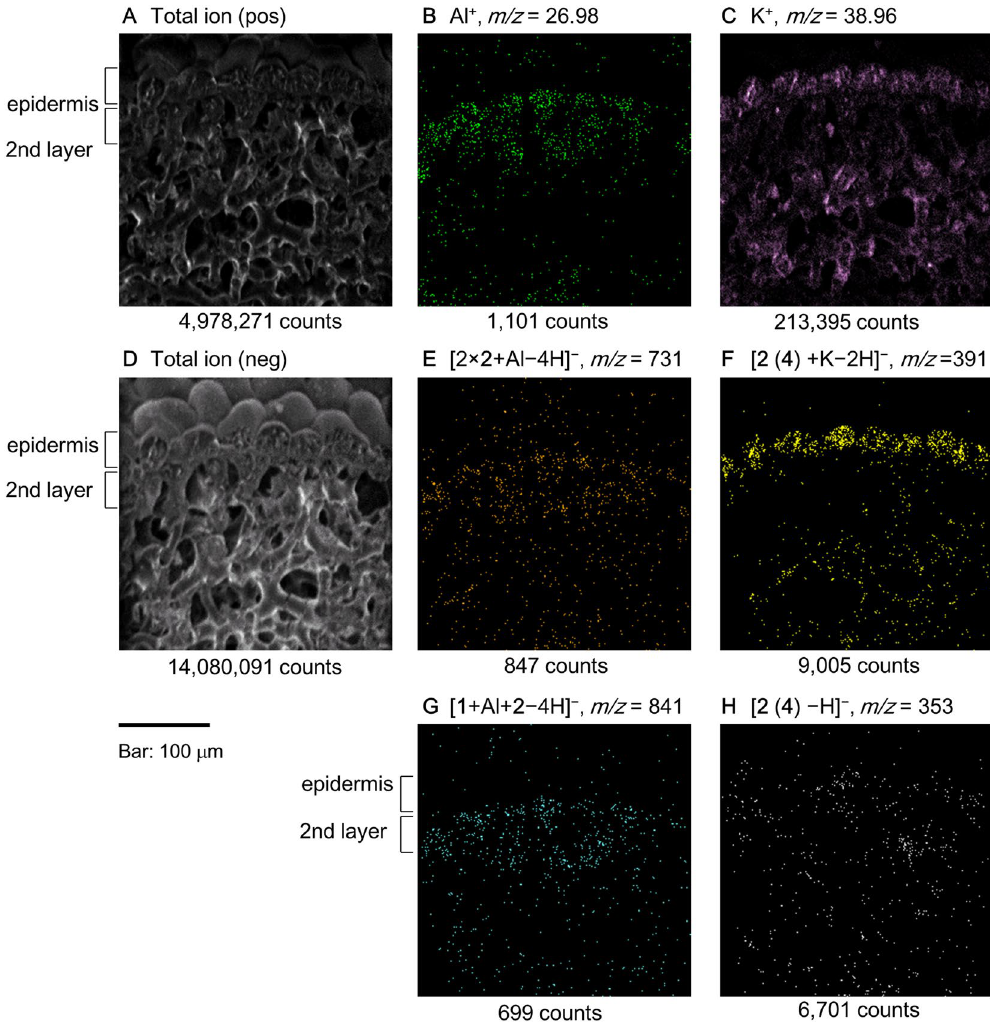
Figure 4. Cryo-TOF-SIMS ion images of the transverse surface of blue sepal tissue. ( A ) Total ion distribution inferred by positive mode detection. ( B ) Al + . ( C ) K + . ( D ) Total ion distribution obtained by negative detection mode. ( E ) m/z = 731: [2 × 2 + Al–4 H] − . ( F ) potassium adduct of 5- O -caffeoylquinic acid and/ or 3- O -caffeoylquinic acid ( m/z = 391: [ 2 ( 4 ) + K − 2 H] − ). ( G ) hydrangea blue-complex ( m/z = 841: [ 1 + Al + 2 − 4 H] − ). ( H ) 5- O -caffeoylquinic acid and/or 3- O -caffeoylquinic acid ( m/z = 353: [ 2 ( 4 ) − H] –